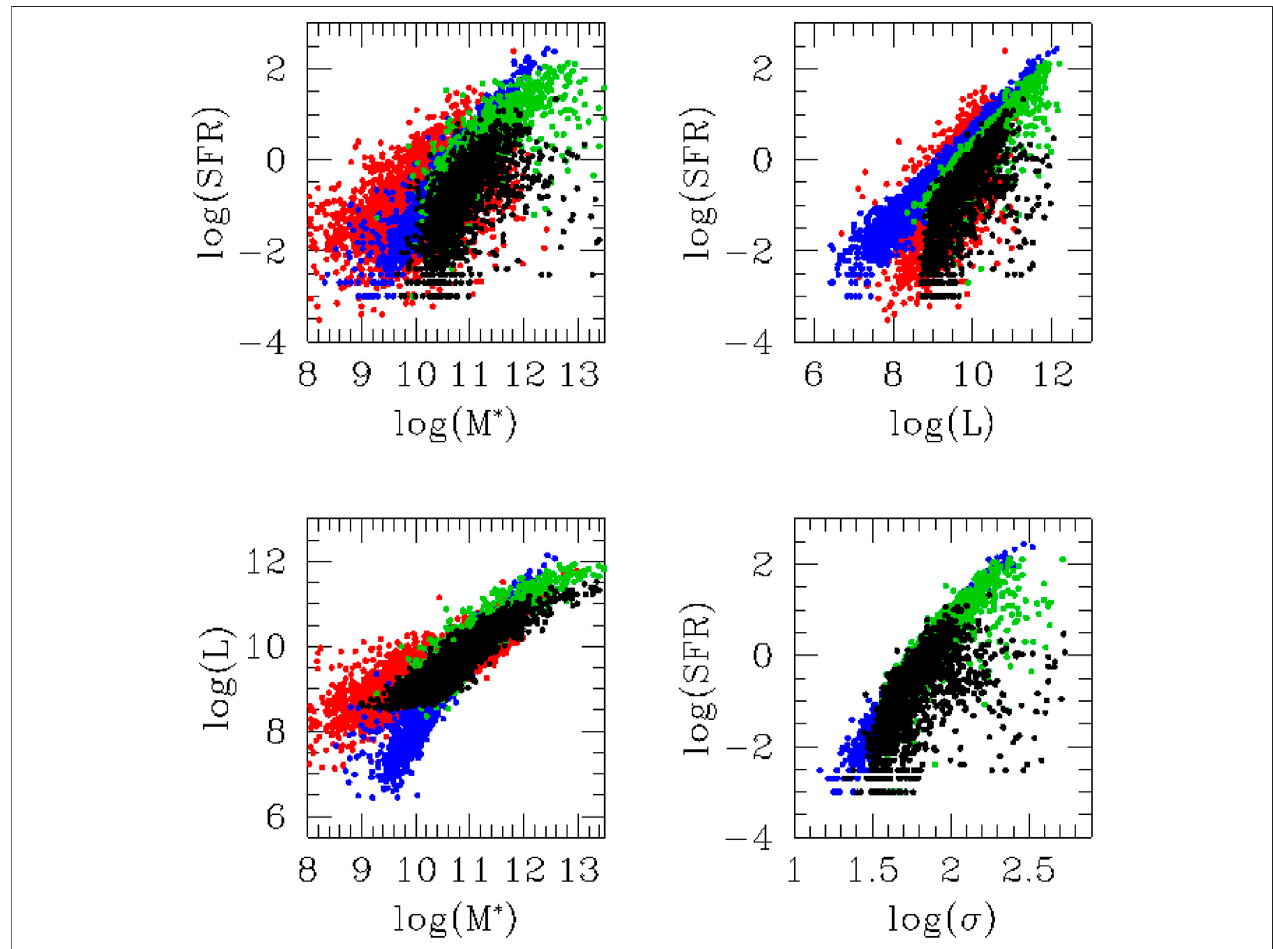
FIGURE 7 | The correlations between M s , L V , SFR , and σ . Mass and luminosity are in solar units, SFR in M ⊙ / yr and σ in km s − 1 . The red dots are the observational dataoftheWINGSsurveyforallmorphologicaltypes(Fritzetal.,2007;Fritzetal.,2011).ThebluedotsarethepredictionoftheIllustrissimulationforgalaxiesat z (cid:1) 4.The green dots the prediction at z (cid:1) 1 and the black dots the prediction at z (cid:1) 0. Note the lack of objects with mass below 10 9 M ⊙ at z (cid:1) 0.